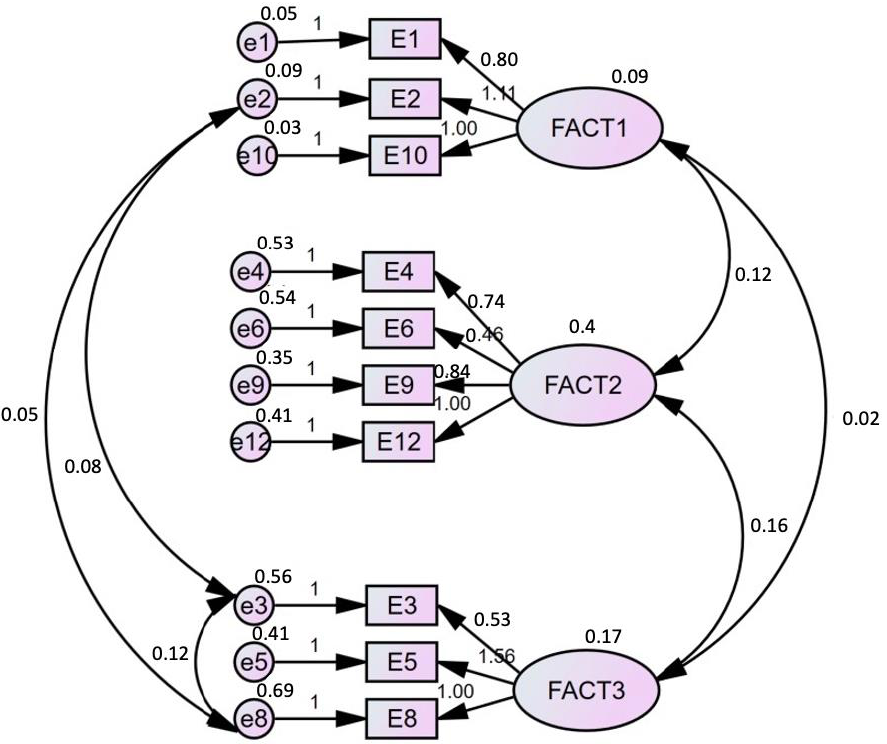
Figure 1. Confirmatory Factor Analysis.